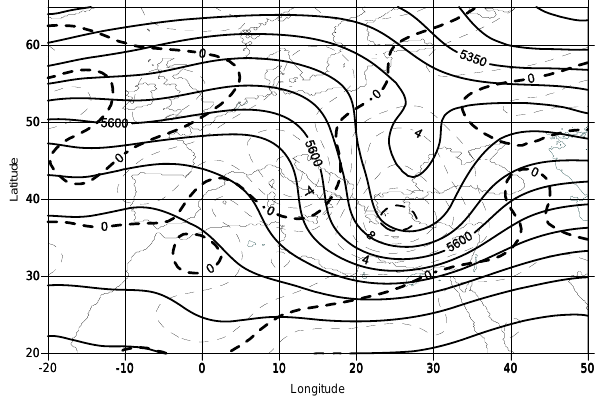
Fig. 8. Geopotential height (solid lines, gpm)